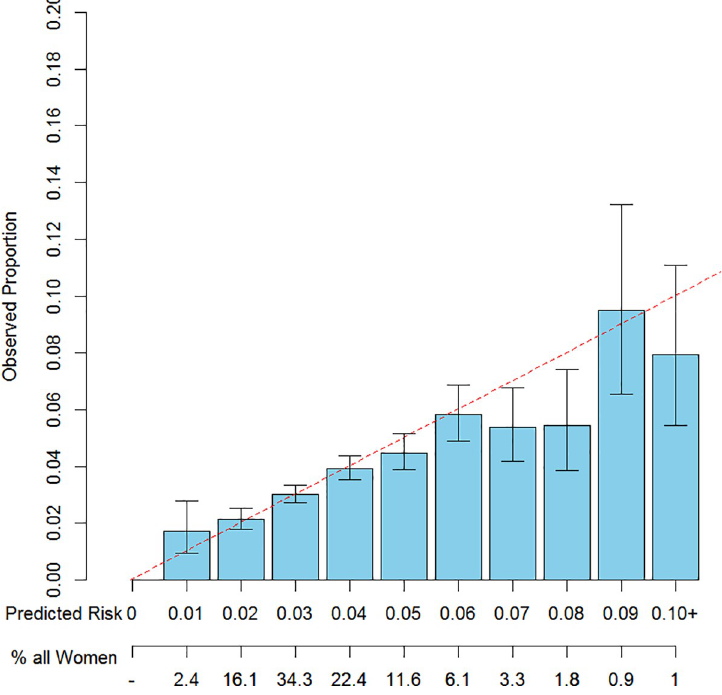
Fig 3. Observed vs. expected counts of 5-year absolute risks vs. 1% risk bins, of 10-fold cross-validated predicted risks using Model 3a.